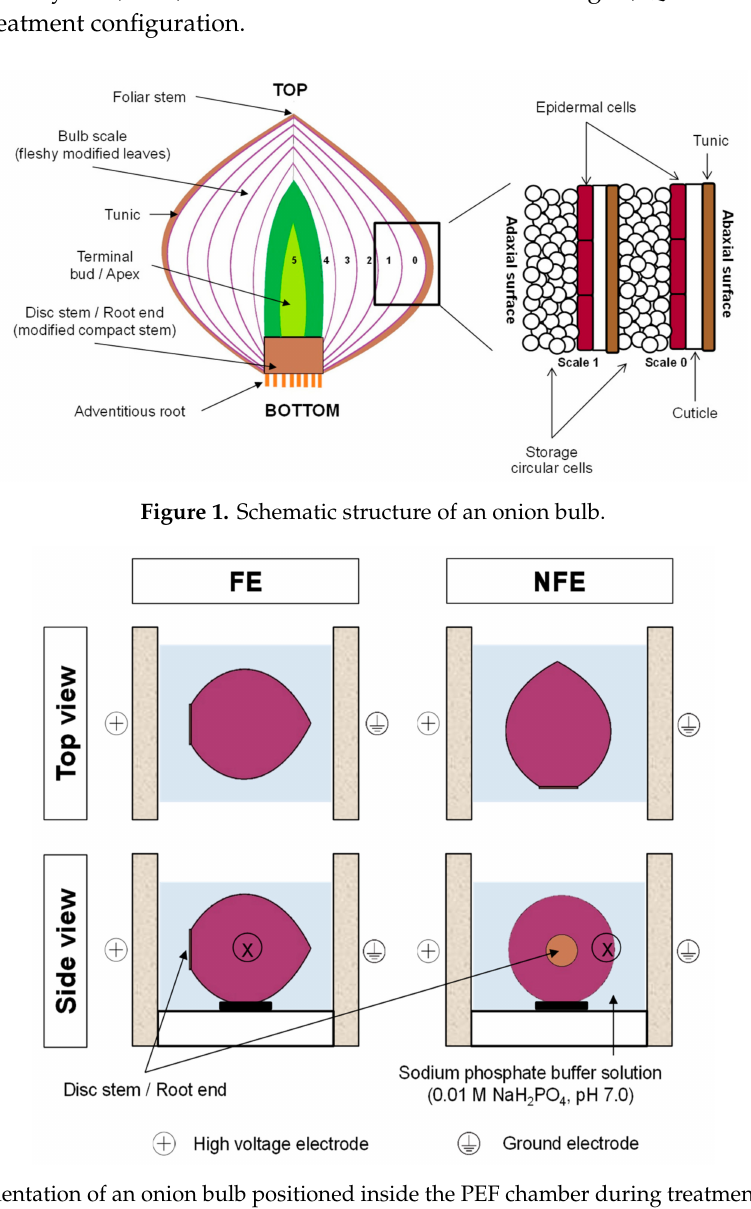
Figure 2. Orientation of an onion bulb positioned inside the PEF chamber during treatment. The onion bulb was positioned with either the root end facing the electrode (FE) or the root end not facing the electrodes (NFE). “X” indicates the equatorial area of the onion bulb where specimens were later taken for cryogenic-scanning electron micrographs (cryo-SEM)